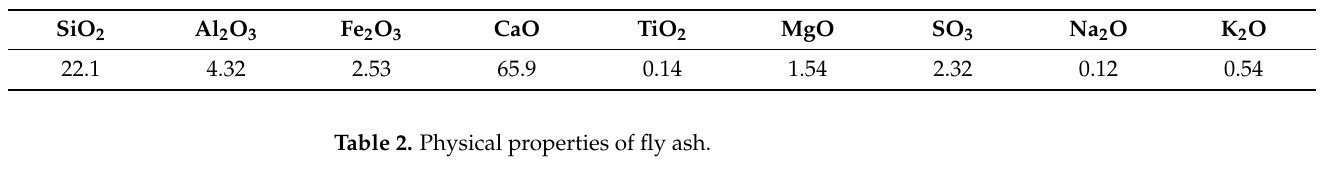
Table 1. Chemical composition of cement (%).